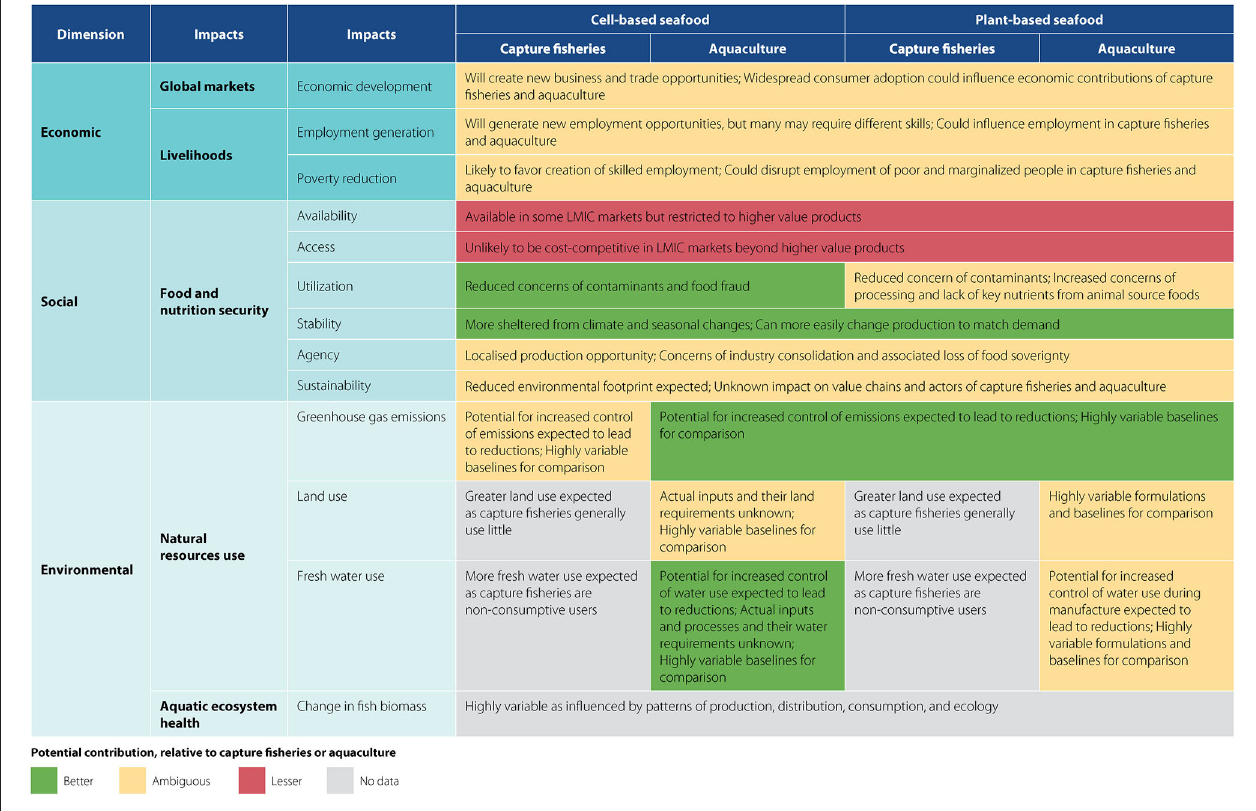
FIGURE 1 | Summary of the economic, social and environmental contributions of alternative seafood production, trade and consumption in LMIC food systems by 2030, as compared to capture fisheries and aquaculture. Source: Authors’ interpretation of the literature cited in this